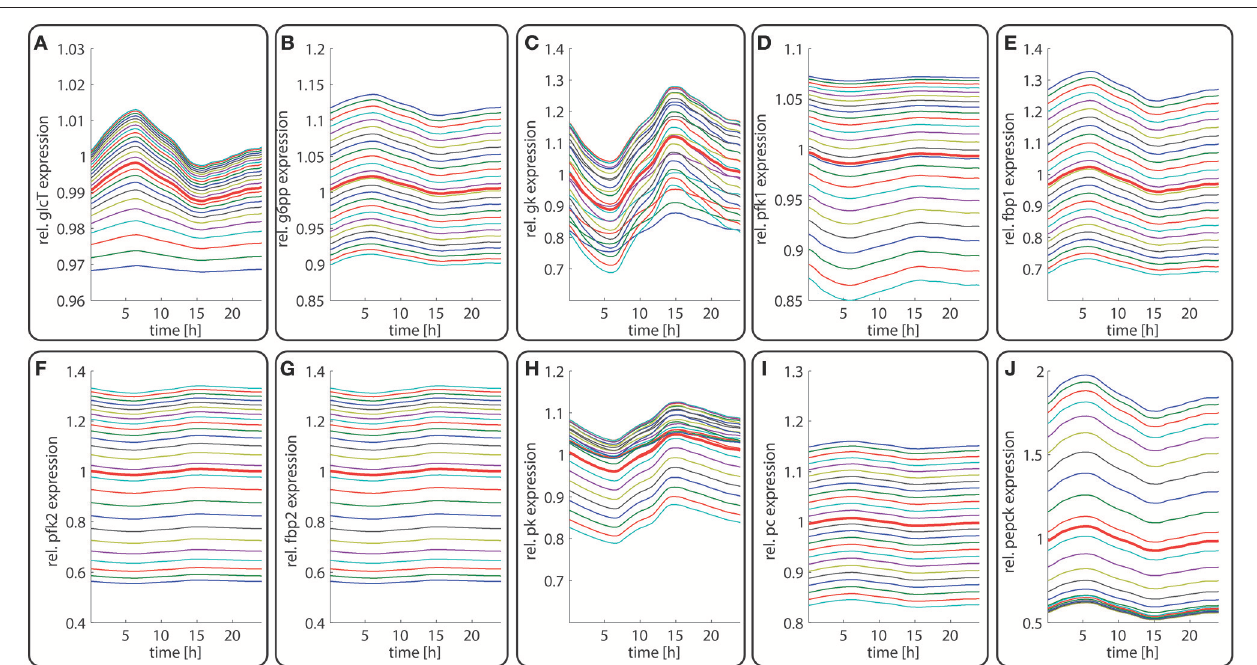
FIGURE 4 | Diurnal variations in the relative abundance of glycolytic and gluconeogenetic enzymes within hepatocytes along the porto-central axis of a well-fed rat. The curves illustrate the relative deviation of protein abundances from the overall spatial and 24h- mean ( = 24h mean of the bold red curve). From the top to the bottom, the different curves refer to the spatial position of the hepatocyte counted from periportal to percentral. The bold red line refers to the average protein abundance across all cells. (A) GlcT, (B) G6PP, (C) GK, (D) PFK1, (E) FBPPFK1, (F) PFK2, (G) FBPPFK2, (H) PK, (I) PC, (J)